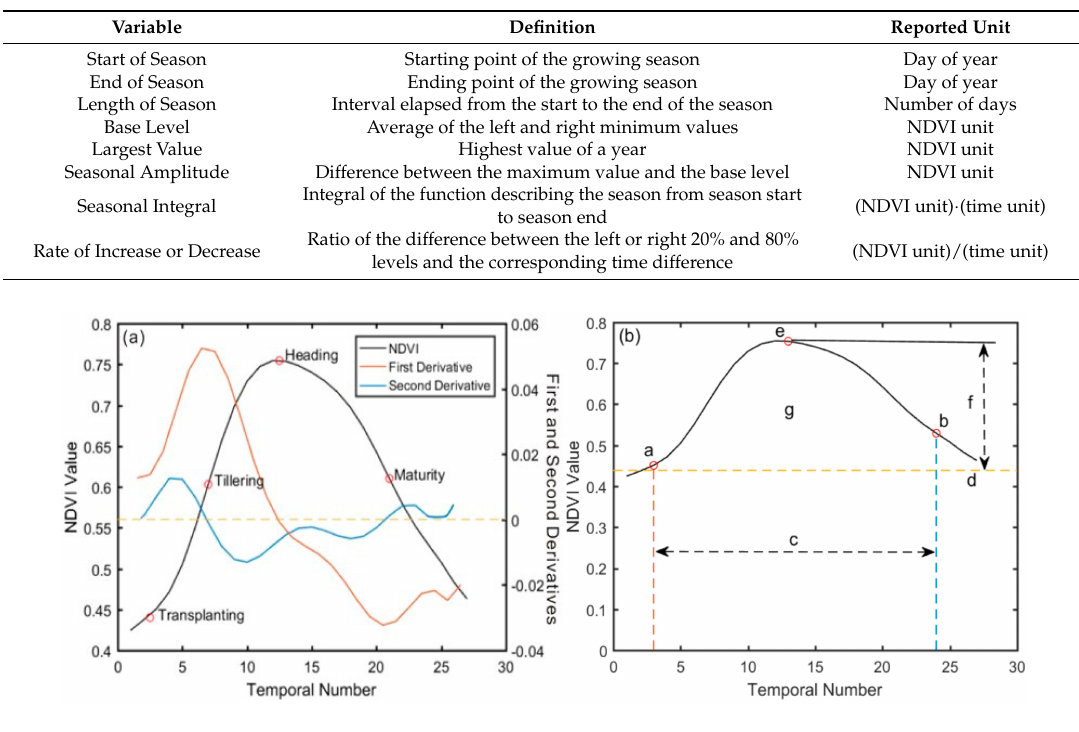
Figure 3. ( a ) The extraction of four key phenological stages (transplanting, tillering, heading and maturity stage) based on the first and second derivative of NDVI curve. ( b ) Application of dynamic threshold method to obtain other phenological parameters of rice. a–g represent the start of the season, the end of the season, length of the season, base level, largest value, seasonal amplitude, and seasonal integral,